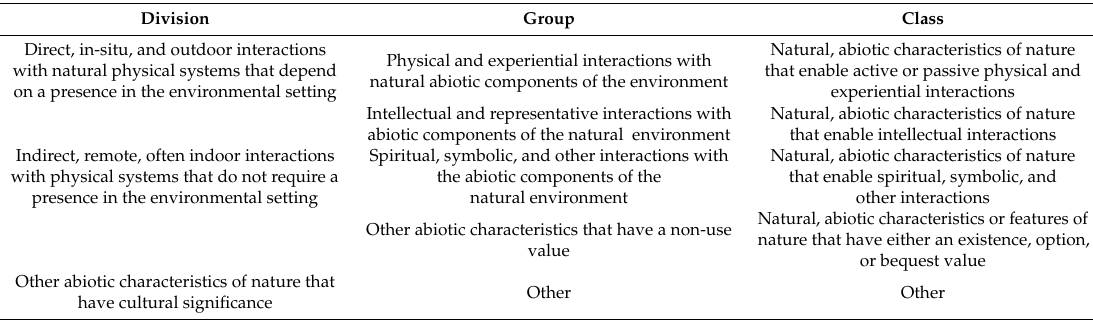
Table 3. Cultural Abiotic ecosystem services according to CICES Extended